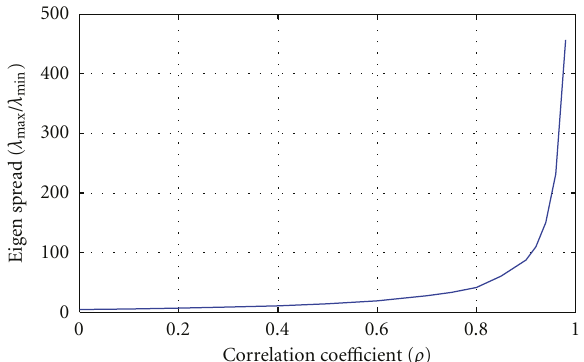
Figure 2: CDF of Spectral E ffi ciency when Basestations employ two antennas